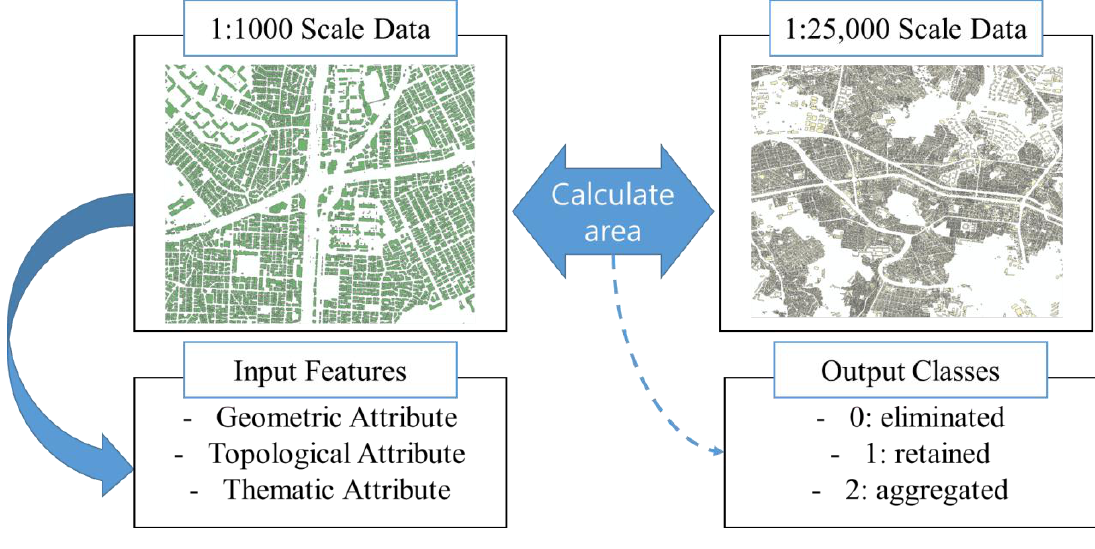
Figure 3. Schematic of the building classification.